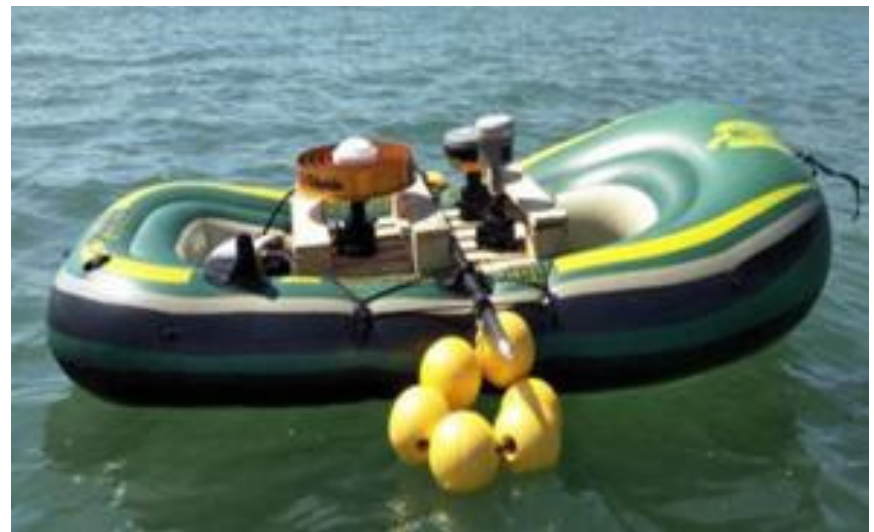
Figure 11. Dynamic test carried out by using Trimble R10 receiver on an inflatable boat.